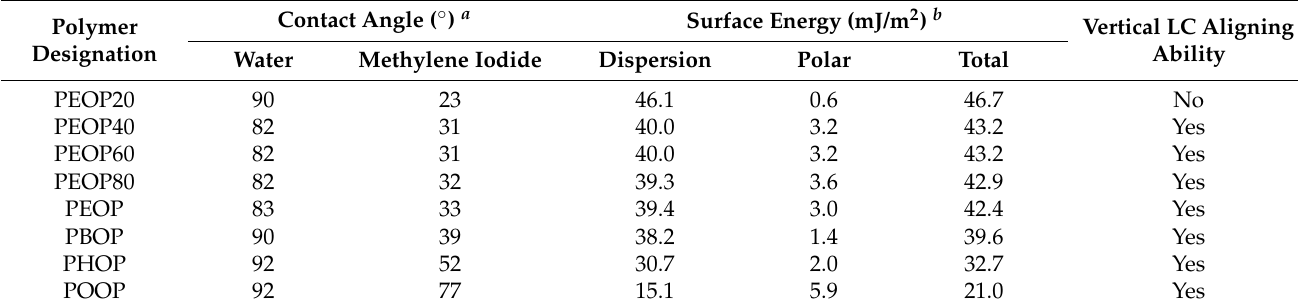
Figure 6. Contact angle of water and methylene iodide on polymer films fabricated with ( a ) PEOP# and ( b ) PAOP, ( c ) surface energy and LC orientation behaviors. Upper and lower parts around the broken line indicates random planar and vertical LC orientation behaviors, respectively. Table 2. Surface energy and LC orientation properties of the polymers.